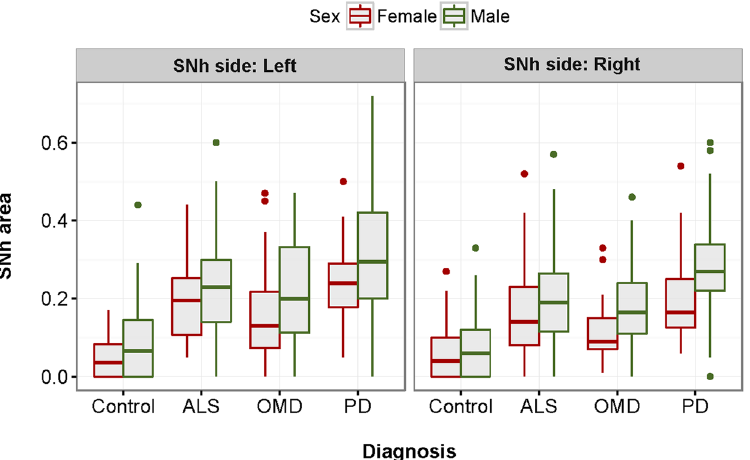
Figure 1. SNh area in different subgroups of patients and controls according to the SNh side and to gender. ALS: amyotrophic lateral sclerosis; OMD: other movements disorders (atypical parkinsonism, vascular parkinsonism and essential tremor); PD: Parkinson’s disease; SNh: hyperechogenicity of the substantia nigra.